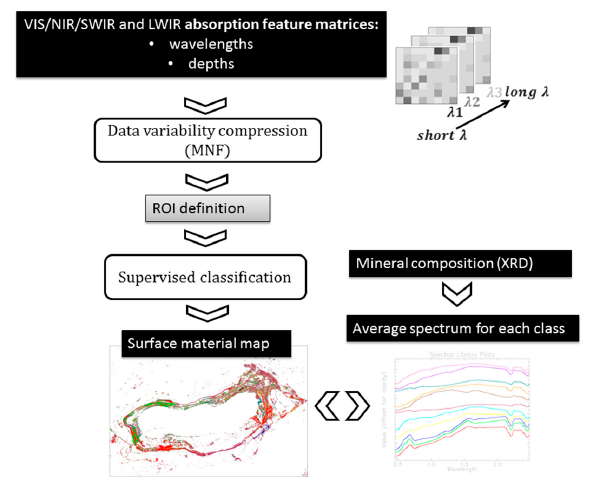
Figure 4. Scheme of the processing allowing integration of the absorption feature information detected in VIS/NIR/SWIR and LWIR data and further classification.